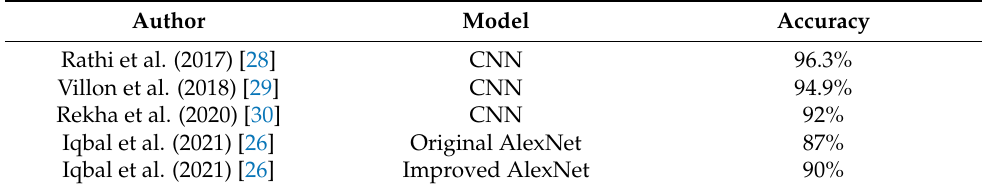
Table 1. Deep learning methods for performance of fish